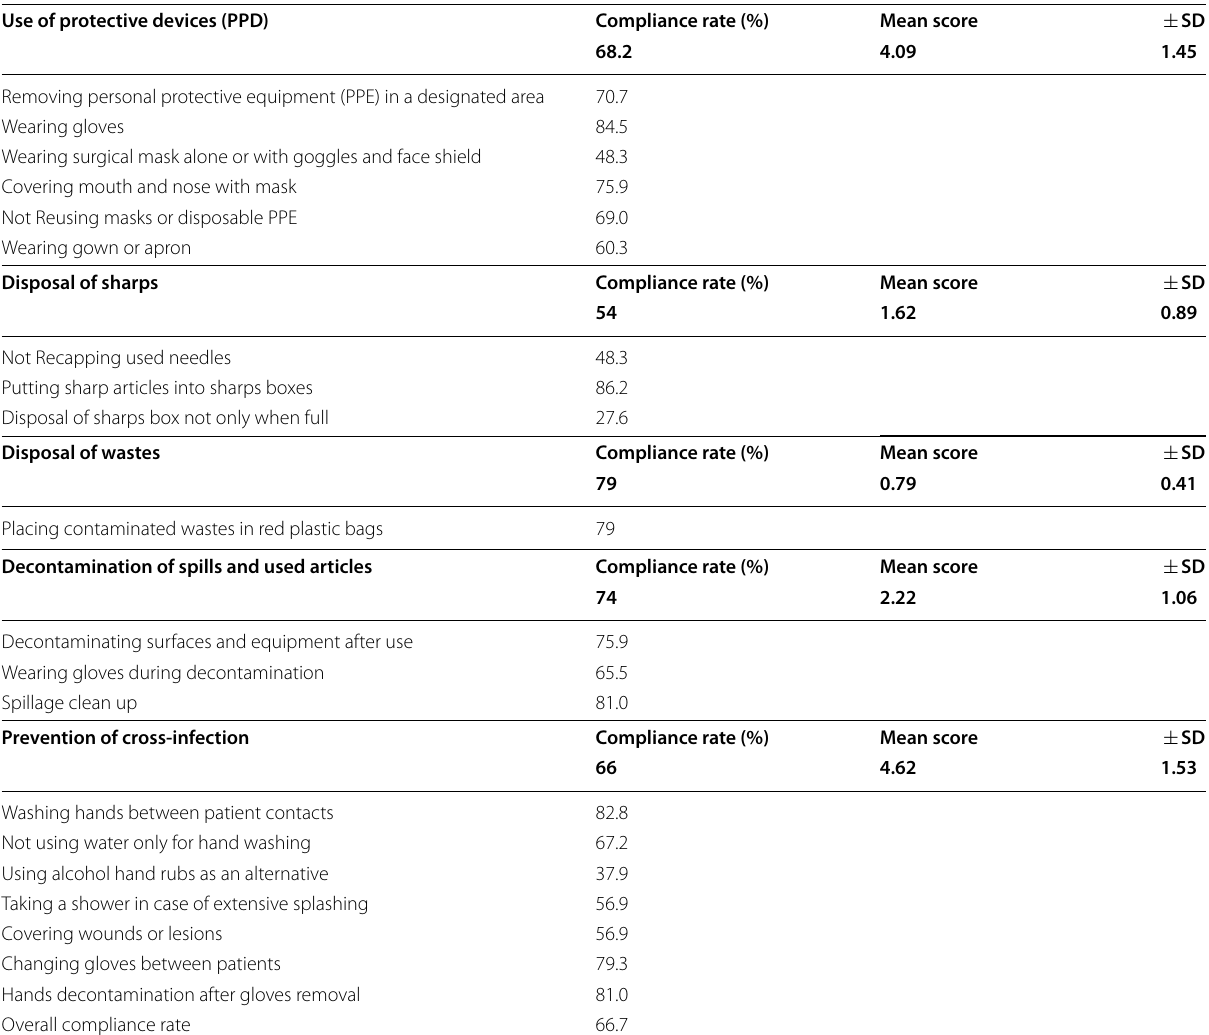
Table 2 Participants’ compliance rates in CSPS items Use of protective devices